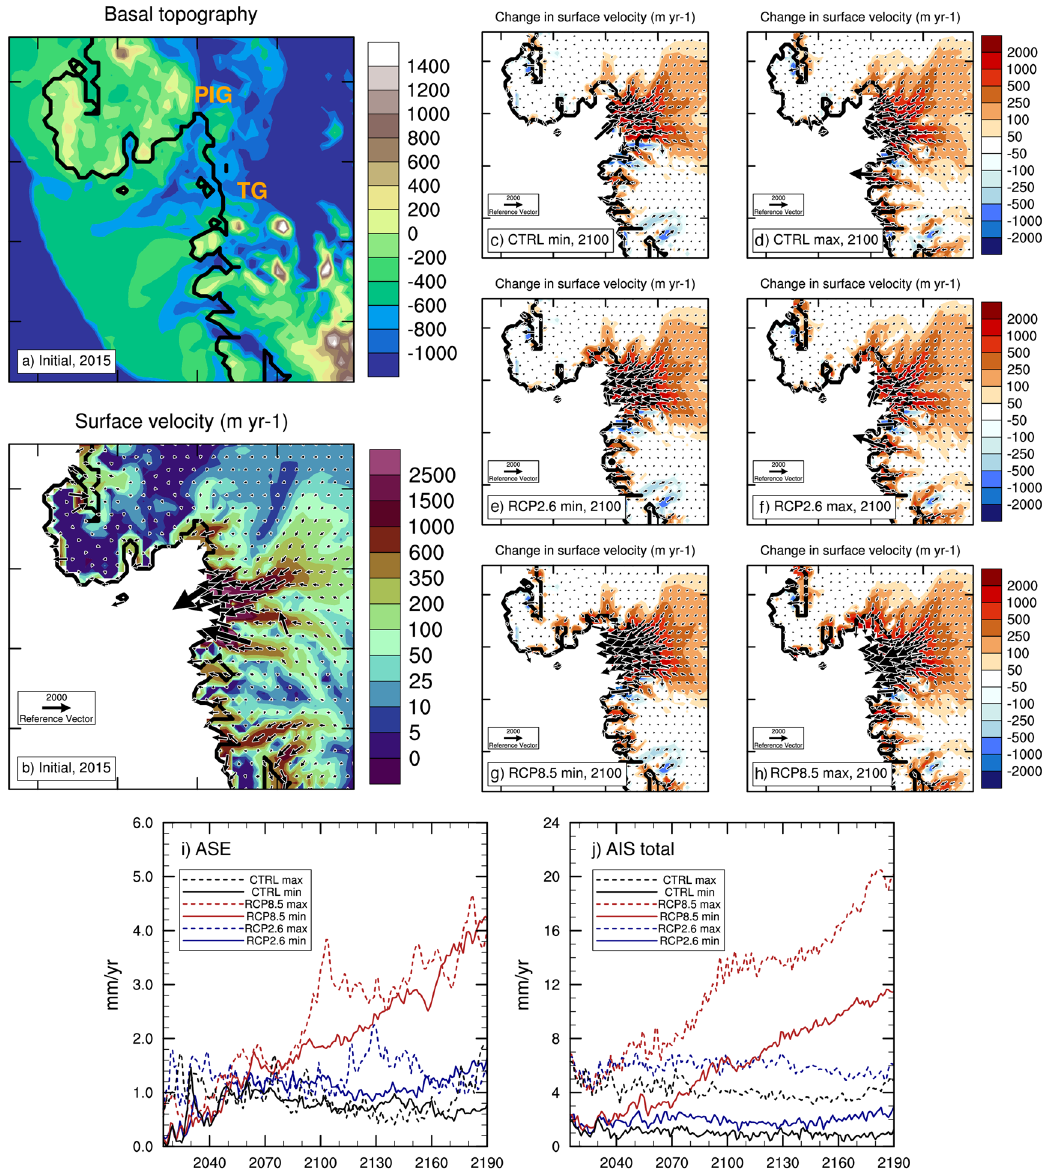
Fig. 3 Surface velocity changes in the ASE. a Initial basal topography and b surface ice velocity of the Amundsen Sea Embayment (ASE). PIG and TG refer to Pine Island Glacier and Thwaites Glacier, respectively. c – h Change in ice surface velocity at 2100 relative to the start of the projection experiment (2015) for the control (CTRL), RCP2.6 and RCP8.5 simulations with the c , e , g minimum and d , f , h maximum AIS sea-level contribution, respectively. The control experiments use present-day climate for the duration of the model run. i , j Rate of sea-level contribution for the simulations shown in panels c through h